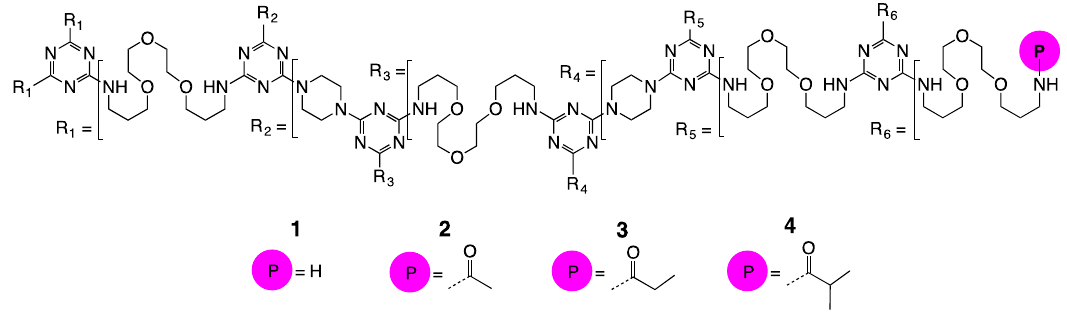
Figure 1. The molecules used in this study.